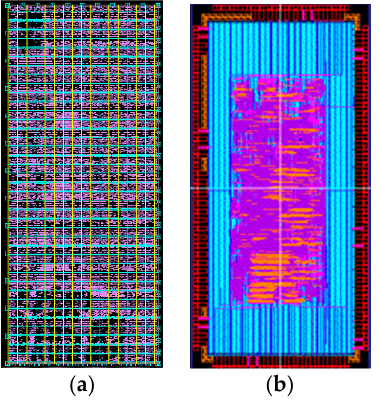
Figure 12. ( a ) Layout of the processor ( b ) Layout of the chip.